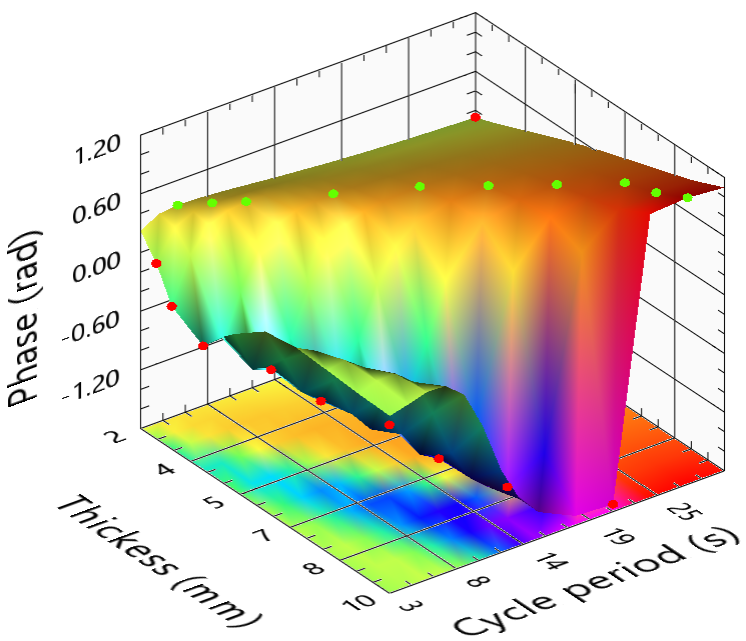
Figure 17. Phase difference function of the sample thickness and cycle period of CFRP